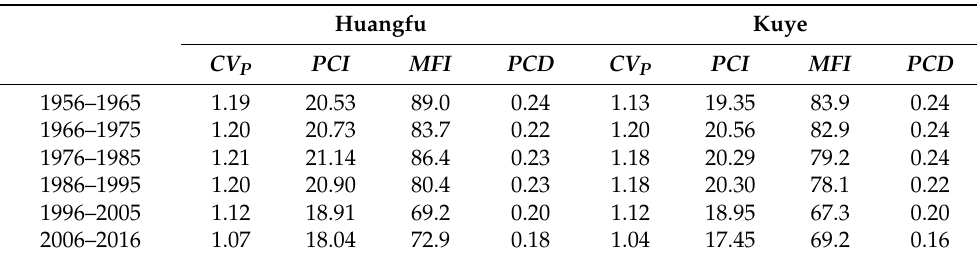
Table 2. Average values of rainfall indexes in different